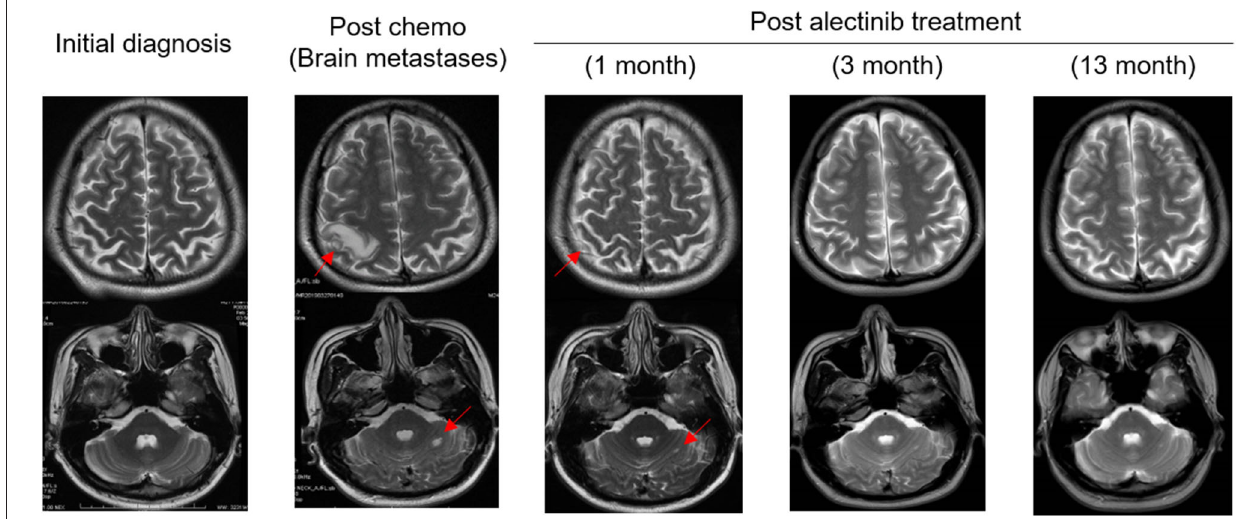
FIGURE 2 | Serial MRI scans showing patient’s metastatic brain tumors responded completely to alectinib therapy. The patient achieved partial response (PR) 1 month after the initiation of alectinib therapy, and the lesions disappeared (CR) completely at the 3- and 13- month post-alectinib treatment time points. Arrows: metastatic brain tumors. CR, complete